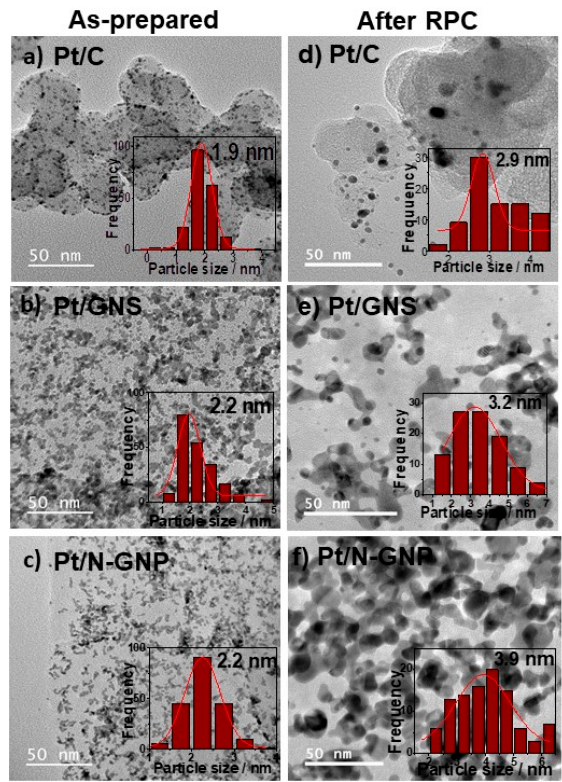
Figure 4. TEM micrographs and histograms of: ( a ) Pt/C; ( b ) Pt/GNS, ( c ) Pt/N-GNP, ( d ) Pt/C(RPC), ( e ) Pt/GNS, and ( f ) Pt/N-GNP(RPC).